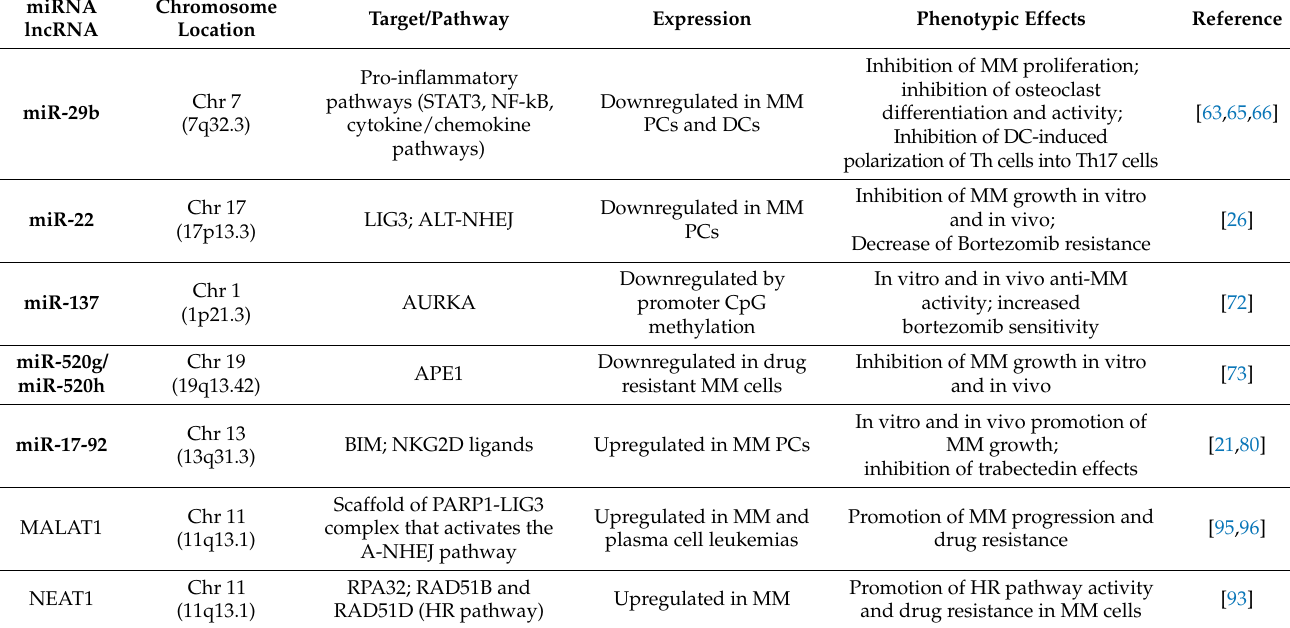
Table 2. ncRNAs regulating GI in MM. miRNA